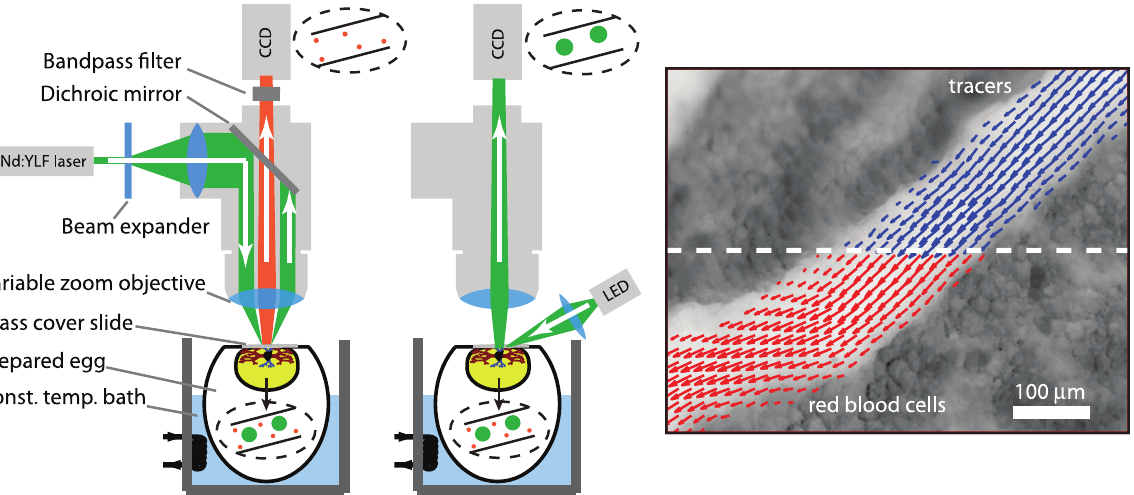
Figure 2. Overview of experimental method. Schematic representation of optical paths for in the vivo flow measurement: (left) using fluorescent tracers illuminated by a pulsed laser and (middle) using red blood cells illuminated by a pulsed LED. (right) A typical result of the measurements: a composite image of the PIV results for the fluorescent tracer particles (top) and red blood cells (bottom).